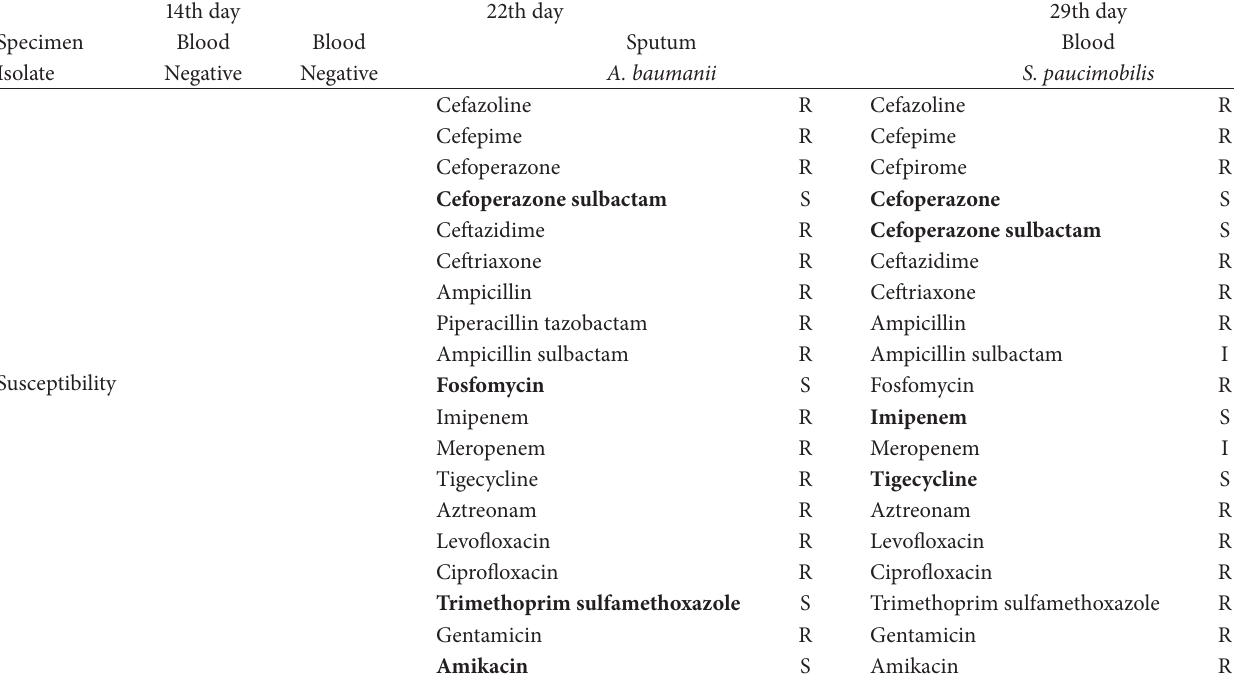
Table 1: The microorganism culture obtained from the